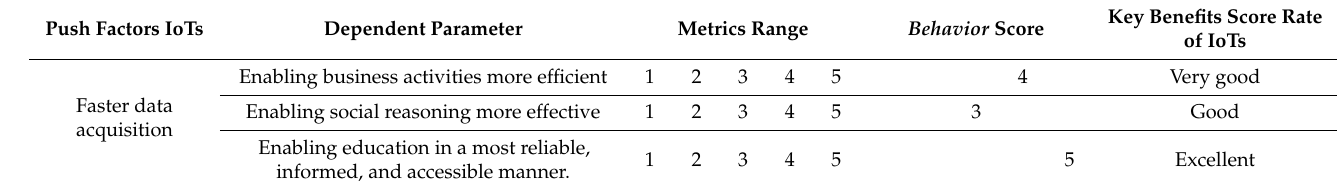
Table 4. The determination of Behavior score of Influence of IoTs based on faster data